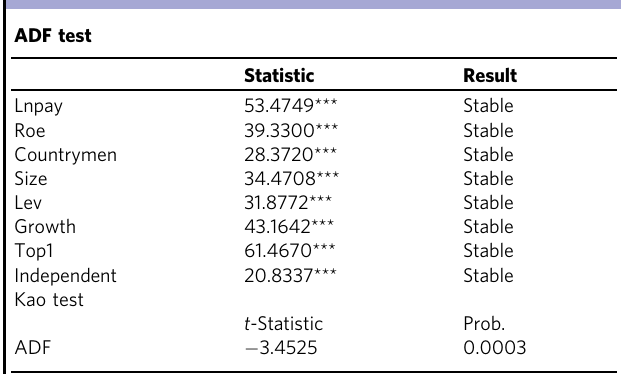
Table 4 Stationarity and cointegration